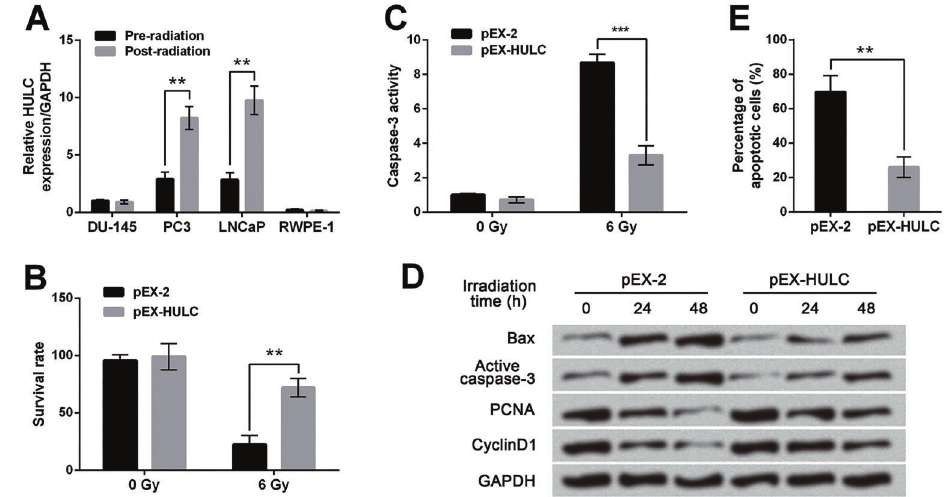
Figure 3. Resistance to irradiation of DU-145 cells was enhanced by HULC overexpression. A , DU-145 was sensitive to irradiation. B , Survival rate of DU-145 cells after irradiation was increased by HULC overexpression. C , Caspase-3 activity of DU-145 cells after irradiation was reduced by HULC overexpression. D , After irradiation, expressions of cell cycle-associated proteins were up-regulated while expressions of apoptosis-associated proteins were down-regulated by HULC overexpression. Data are reported as mean ± SD. **P o 0.01; ***P o 0.001 ( t -test). HULC: long non-coding RNA highly upregulated in liver cancer; pEX-HULC: pEX-2 plasmid carrying full- length HULC; PCNA: proliferating cell nuclear